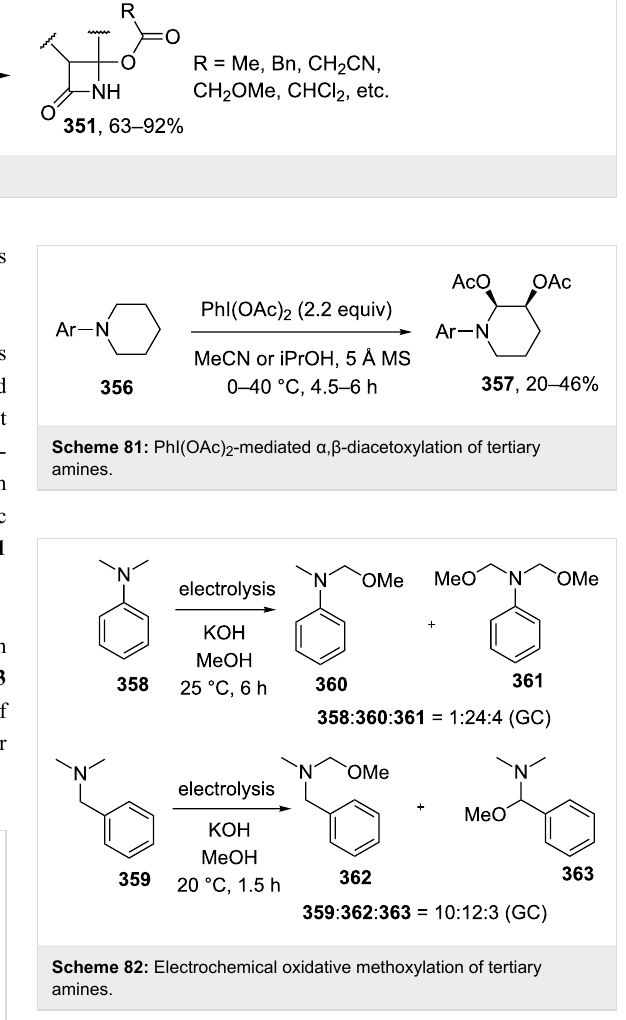
The coupling of N -hydroxyphthalimide with tetrahydrofuran (70% yield) and isochromane (71% yield) takes place in the presence of the CuCl/PhI(OAc) 2 system; CH-reagents are taken in a 10-fold excess (see section 4.4, Scheme 68)